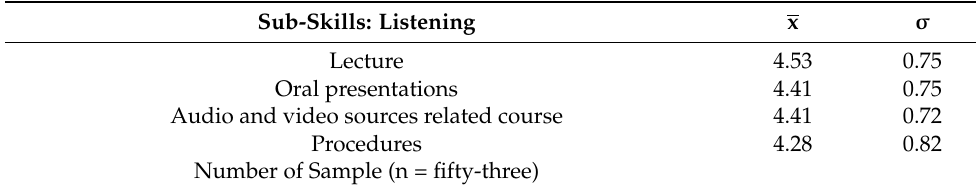
Table 6. The Significance in the Enhancement of Listening Skills.